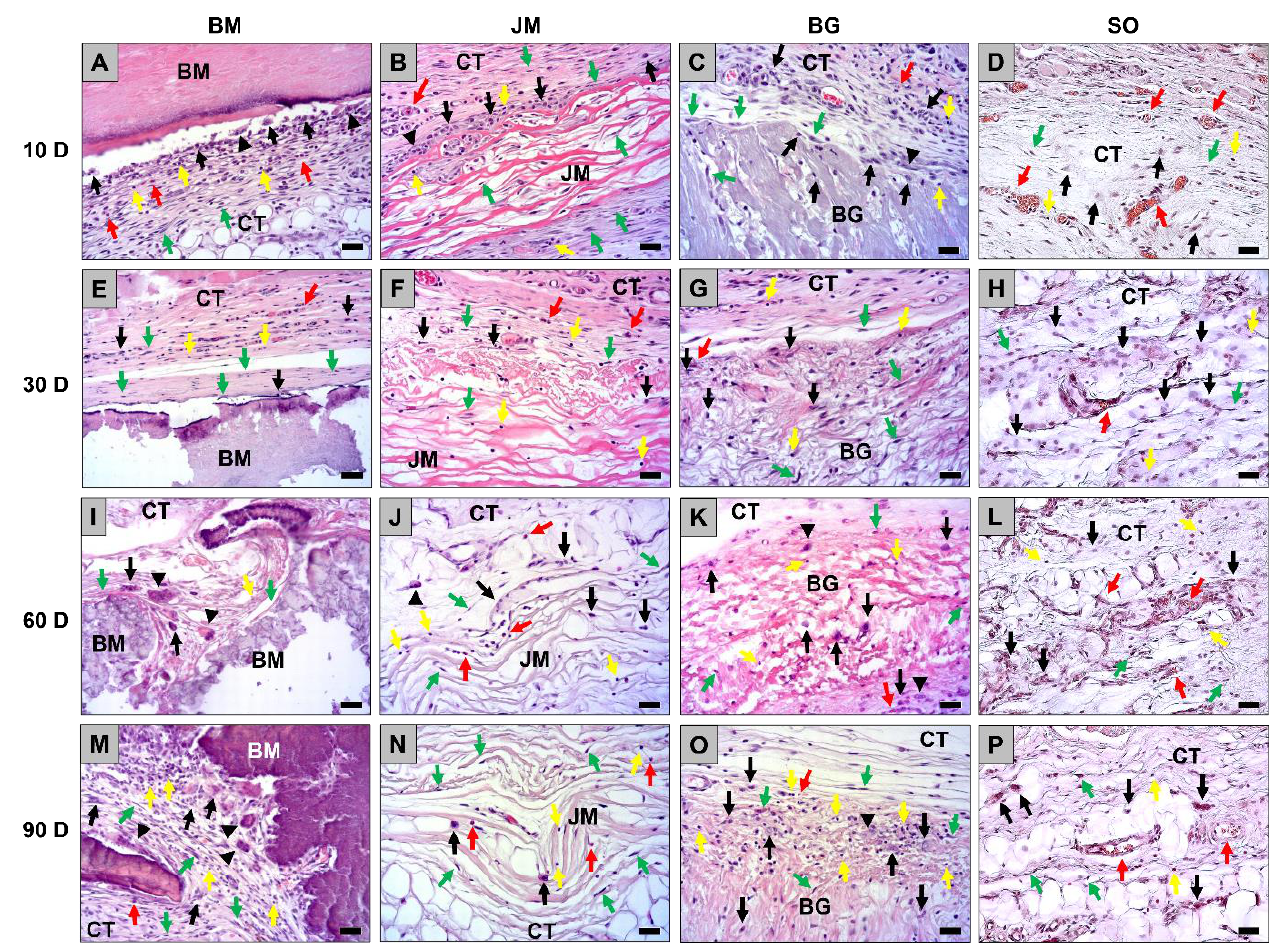
Figure 3. Exemplary histological images of the tissue responses to the three membranes ( A – C , E – G , I – K , M – O ) and the sham operation ( D , H , L , P ) within the subcutaneous connective tissue (CT) at day 10, 30, 60, and 90 post implantationem. Black arrows = macrophages, black arrowheads = multinucleated giant cells, green arrows = fibroblasts, red arrows = eosinophilic granulocytes, yellow arrows = lymphocytes. BM = bovine membrane, JM = Jason ® membrane, BG = Bio-Gide ® membrane, SO = sham operation (H&E-stainings, 200× magnifications, scalebars = 20 µm).